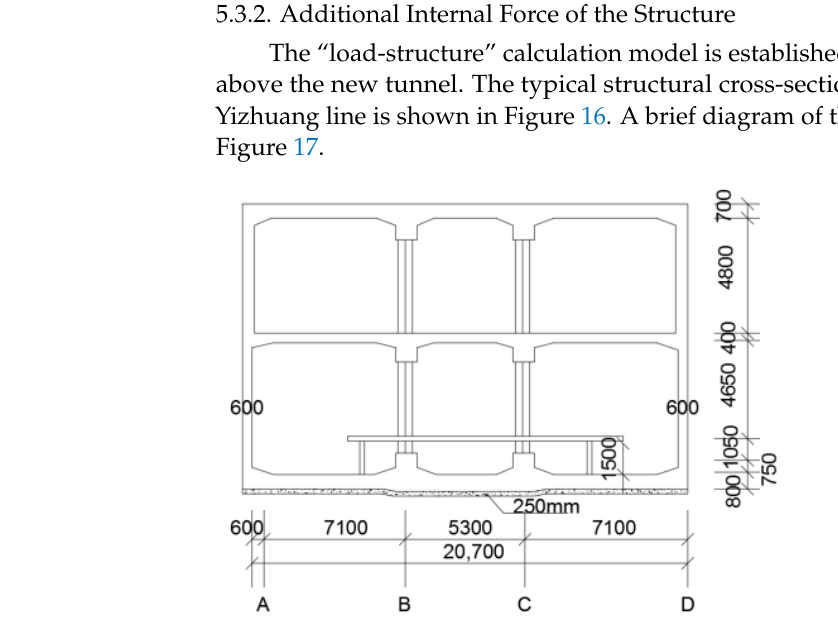
Figure 16. Standard section of existing station structure.